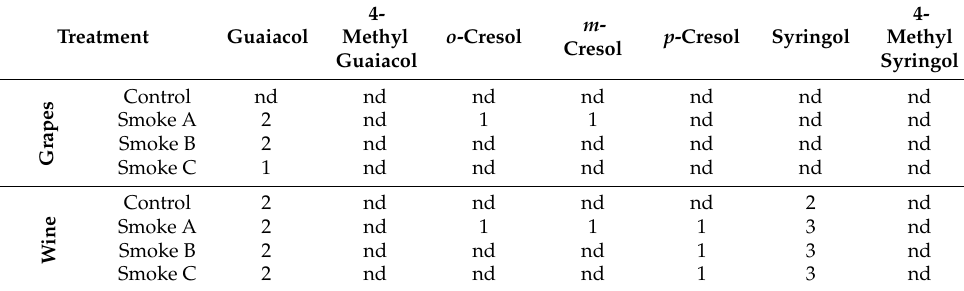
Table 1. Concentrations of volatile phenols in control and smoke-affected Cabernet Sauvignon grapes ( µ g/kg) and wine ( µ g/L).